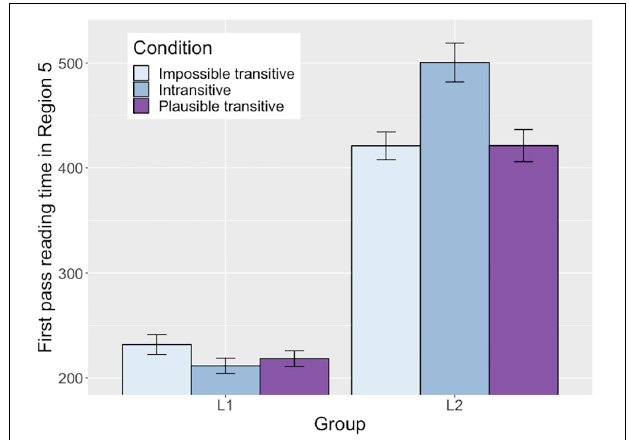
FIGURE 1 | First pass reading time in Region 5 in each condition in each